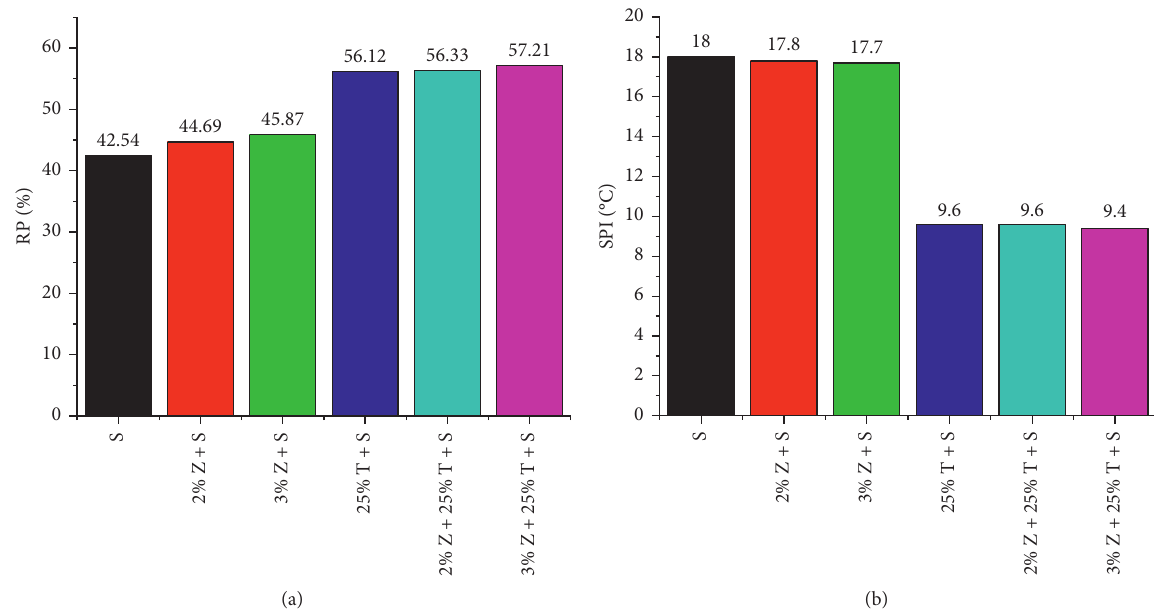
Figure 4: Effect of different content of nano-ZnO (Z) and TLA (T) on physical properties of SBS asphalt (S) after long-term aging. (a) Residual penetration for asphalt. (b) Softening point increment for asphalt.